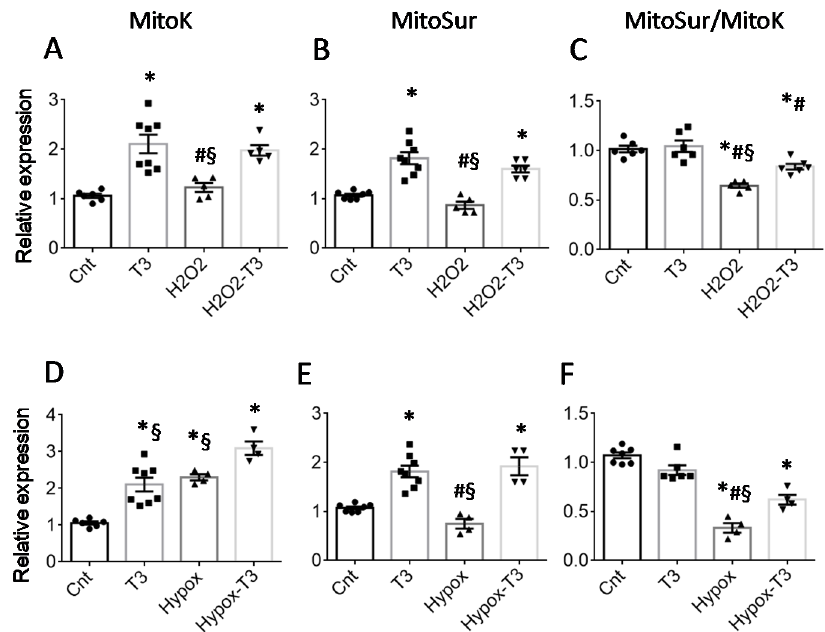
Figure 2. Treatment with T3 induces the expression of mitoK and mitoSur in cultured neonatal rat cardiomyocytes. Upper panels ( A – C ): relative expression of mitoK and mitoSur in NRCM stressed for 6 h with 300 µ M H 2 O 2 and then treated for 48 h with 3 nM T3 or its vehicle. n ≥ 5, * p < 0.03 vs. Cnt; # p ≤ 0.03 vs. T3; § p ≤ 0.04 vs. H 2 O 2 T3. Lower panels ( D – F ): relative expression of mitoK and mitoSur in rat cardiomyocyte cell cultures stressed for 24 h with hypoxia and then treated for 48 h with 3 nM T3 or its vehicle. n ≥ 4, * p ≤ 0.002 vs. Cnt; # p <0.0001 vs. T3; § p < 0.03 vs.